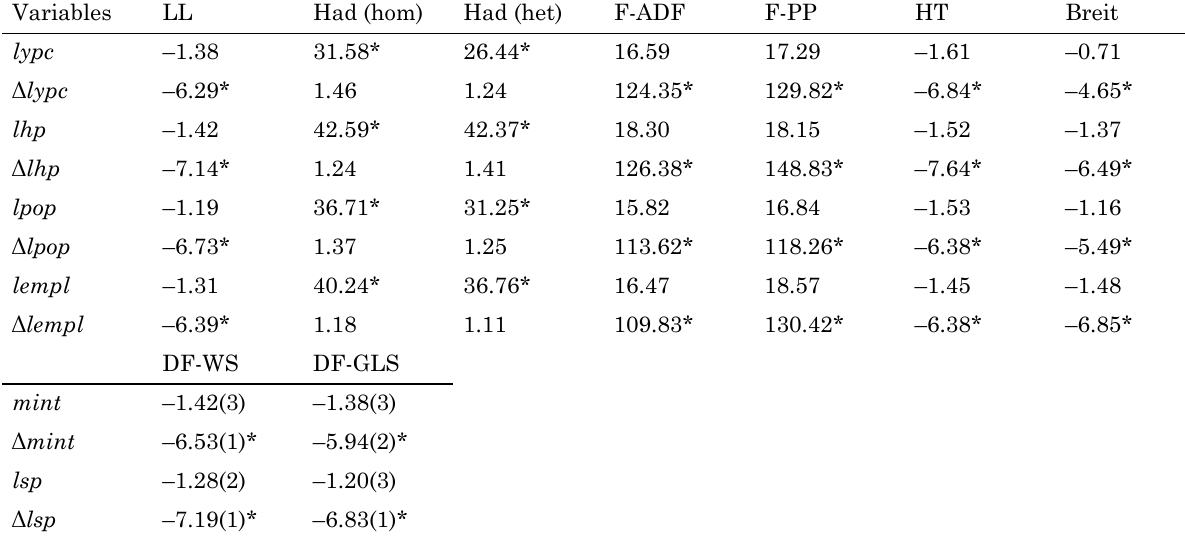
Table B2. Panel unit root tests